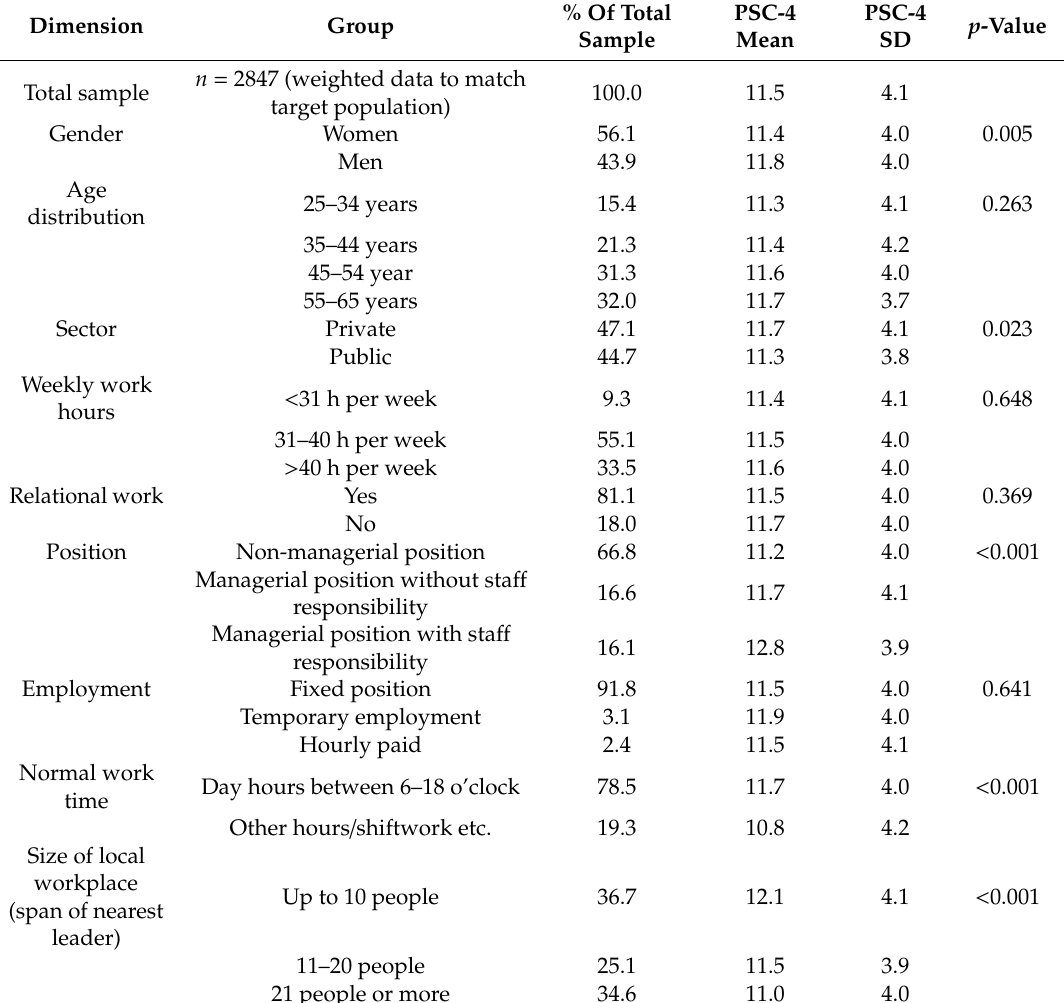
Table 1. Description of respondents based on a random sample of inhabitants in Sweden aged 25–65 years, gainfully employed ( n = 2847); Psychosocial Safety Climate (PSC)-4 mean and Standard Deviation (SD); and p -values for the di ff erence in PSC-4 mean scores between subgroups based on demographic and work-related characteristics.